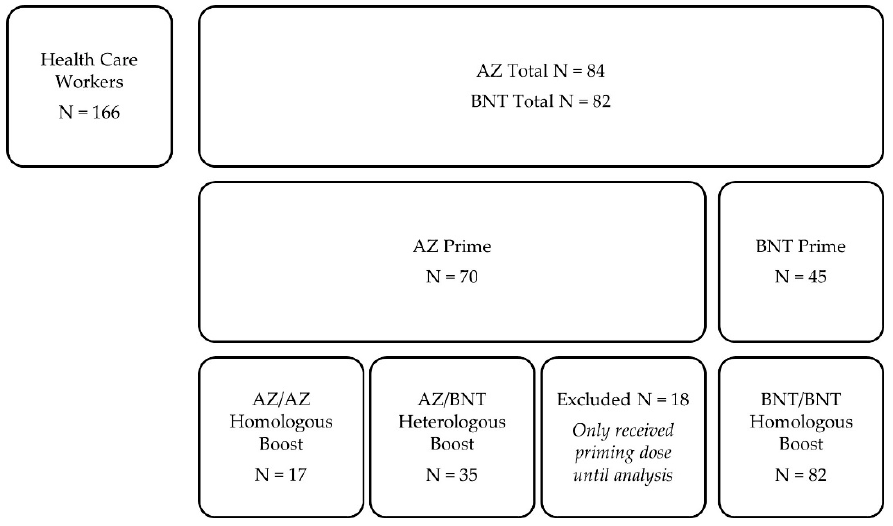
Figure 1. Flow chart on participants’ vaccination patterns. AZ, AstraZeneca; BNT, BioNTech; N, number.